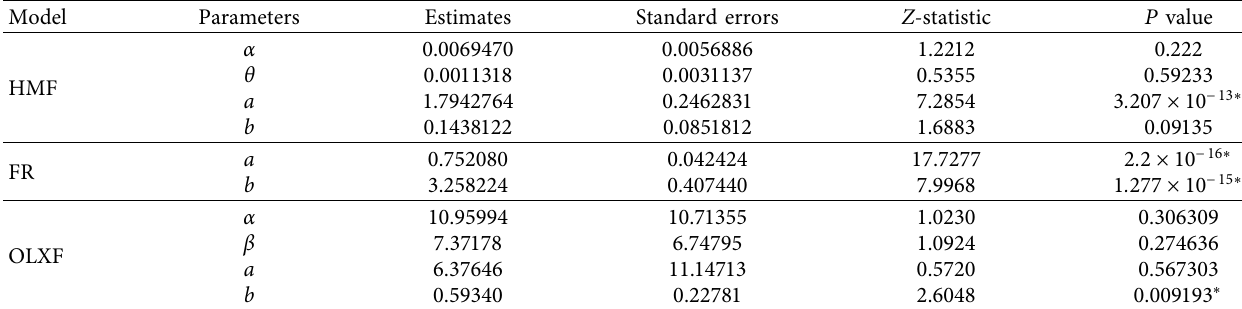
Table 13: MLEs for bladder cancer